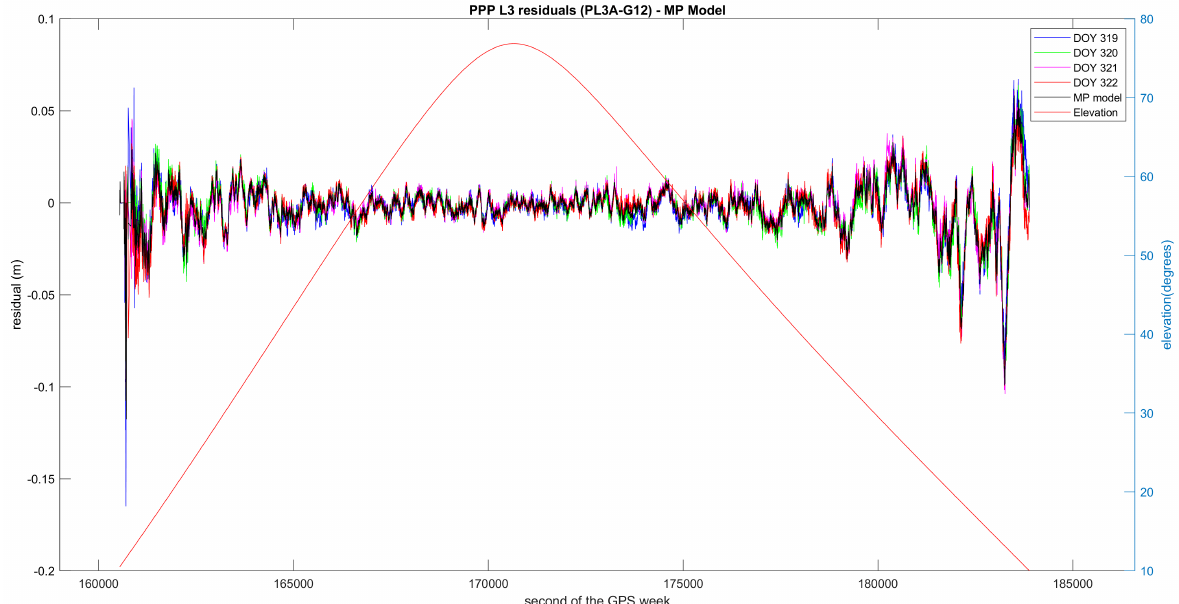
Figure 6. PPP residuals from four consecutive days after matching using azimuth and elevation for the entire observation session. The GPS time is referred to the first day (2016 DOY 319). The obtained multipath model is shown in black.